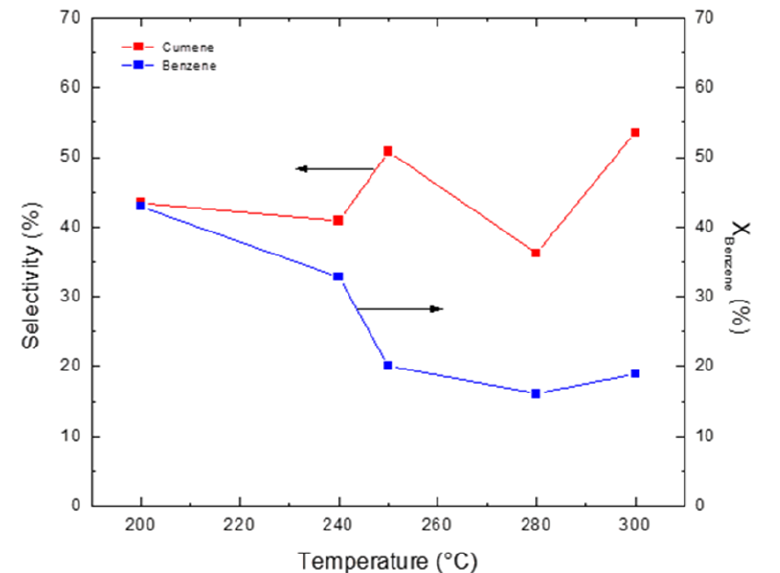
Figure 5. Activity and selectivity of the benzene alkylation reaction with propylene in a membrane reactor across various